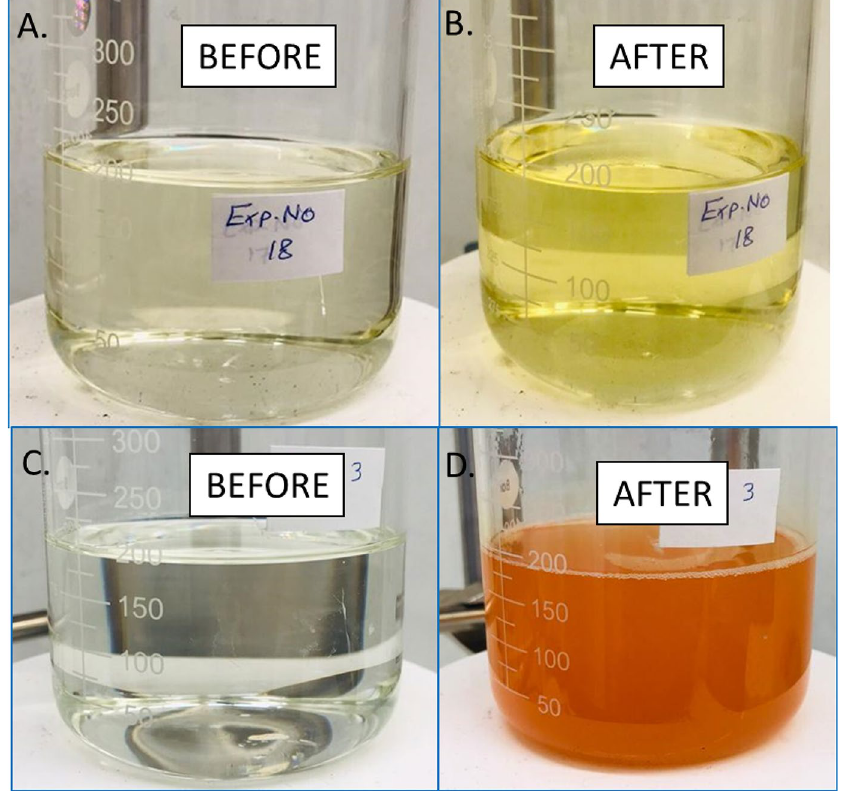
Figure 7. Electrolyte solution of GLDA 5 wt.% + DTPAK 5 5 wt.% (top) and DTPAK 5 10 wt.% + K 2 CO 3 9 wt.% (bottom) . The conditions for the top are (1000 rpm, current density 5 mA/cm 2 ) while for the bottom (2000 rpm, current density 50 mA/cm 2 ).